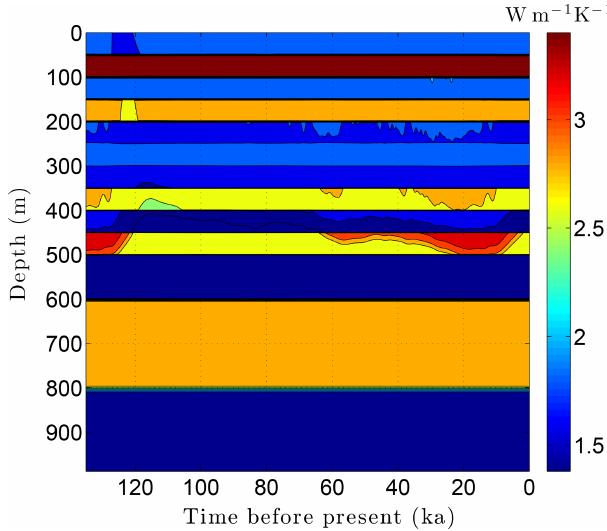
Figure 10. Ice content φ i variations over the last ice-age cycle within the example sedimentary sequence (Fig. 8). Unfrozen water φ (cid:96) variations (not shown) mirror the ice content fluctuations.